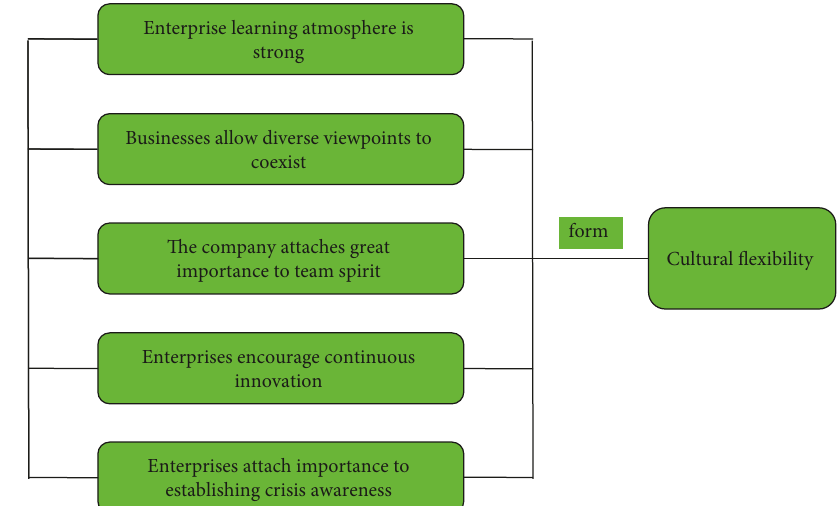
Figure 4: Formation of cultural flexibility